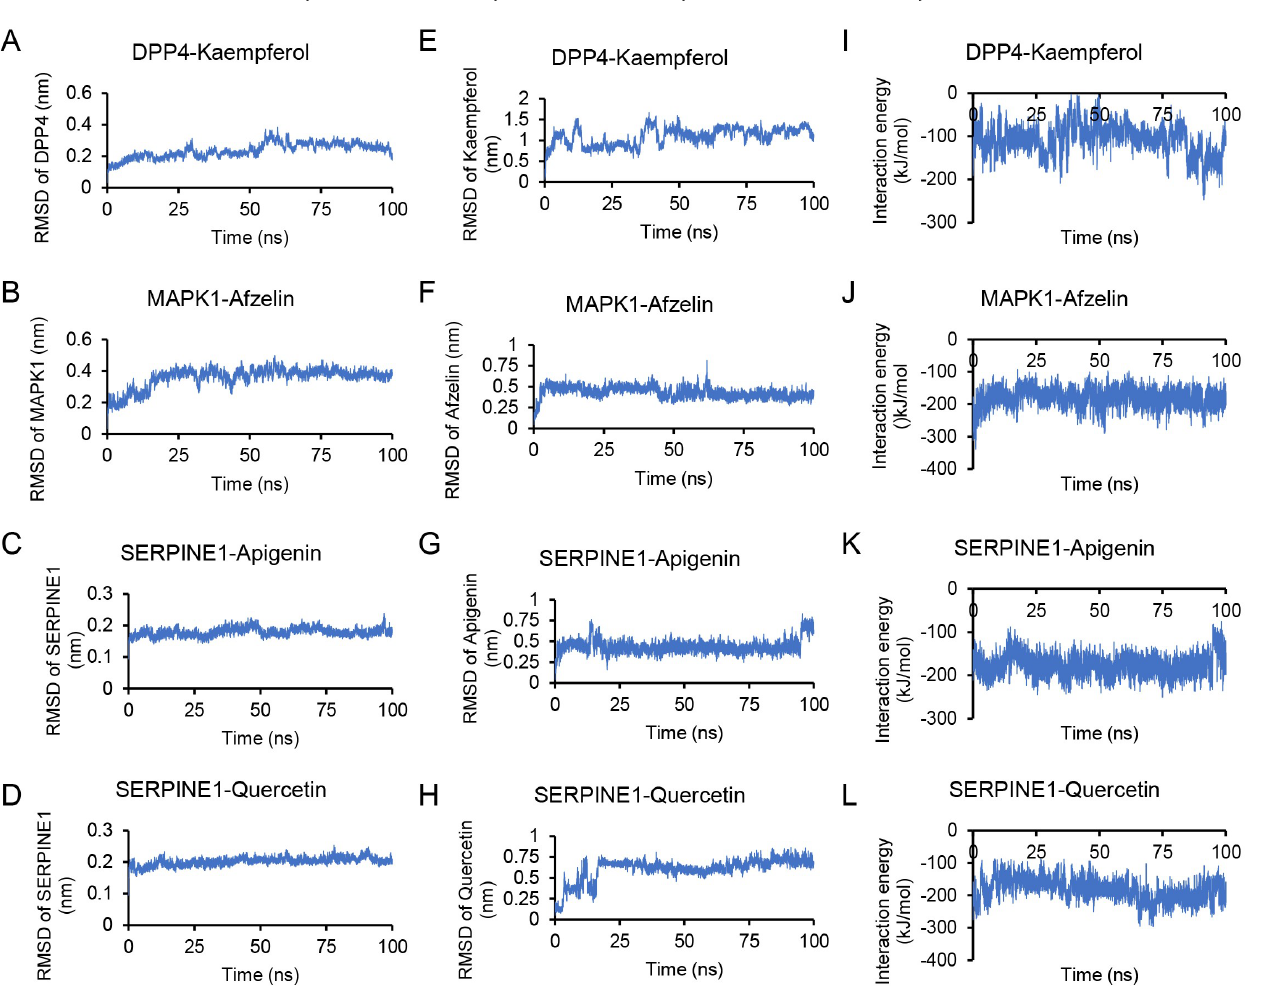
during 100 ns simulation ( L